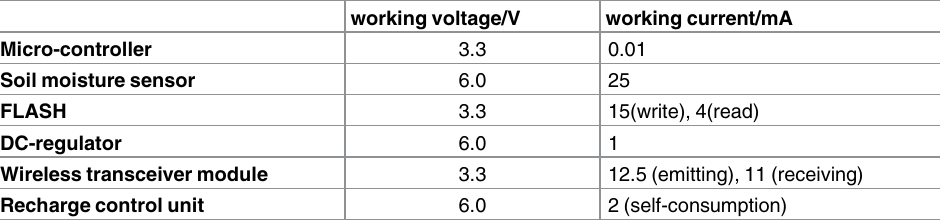
Table 3. Power consumption of